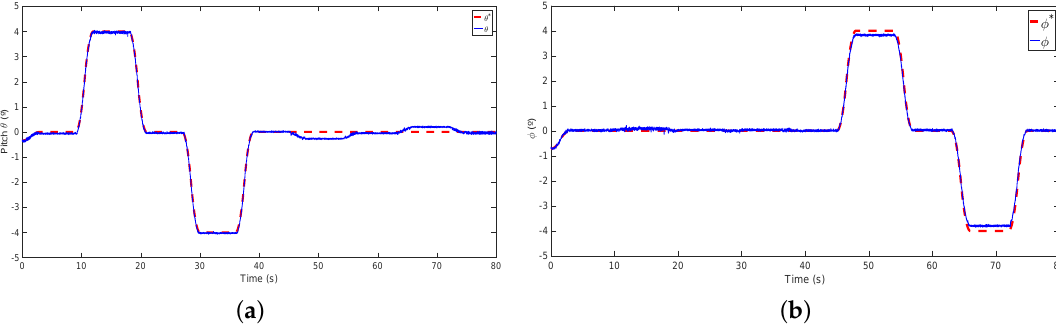
Figure 21. ( a ) θ using the proposed control system; ( b ) φ using the proposed control system.